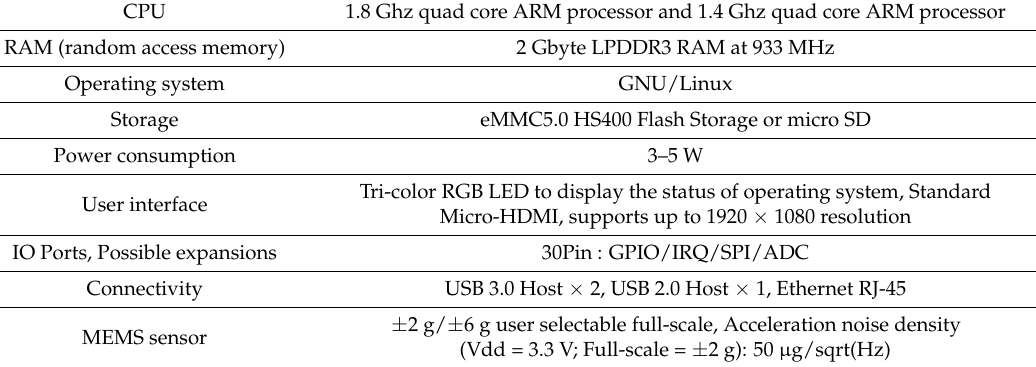
Table 4. Technical specifications of the microcomputer